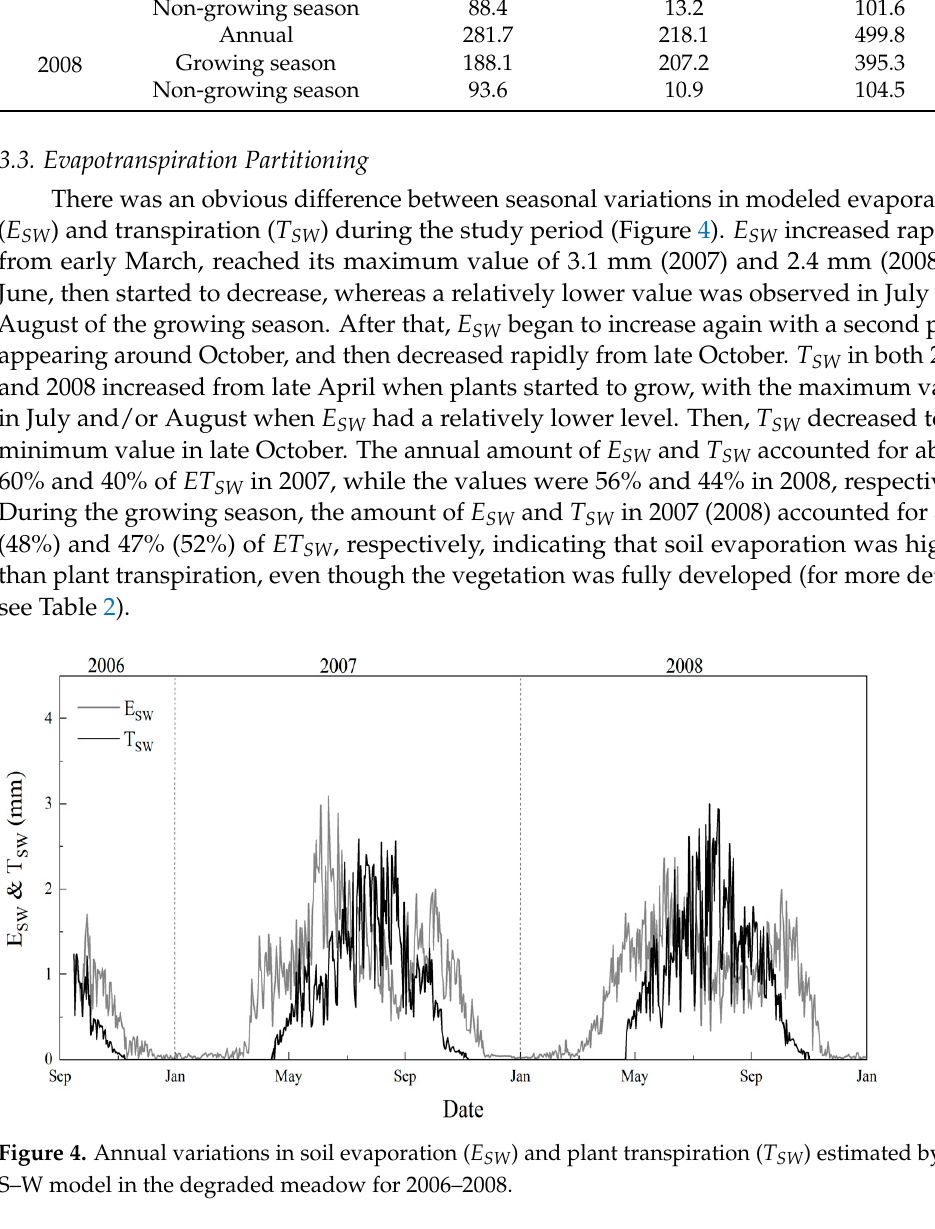
Figure 5. Seasonal dynamics of the ratio of monthly soil evaporation to monthly evapotranspiration ( E SW / ET SW ) estimated from the S–W model in degraded meadow for 2006–2008.